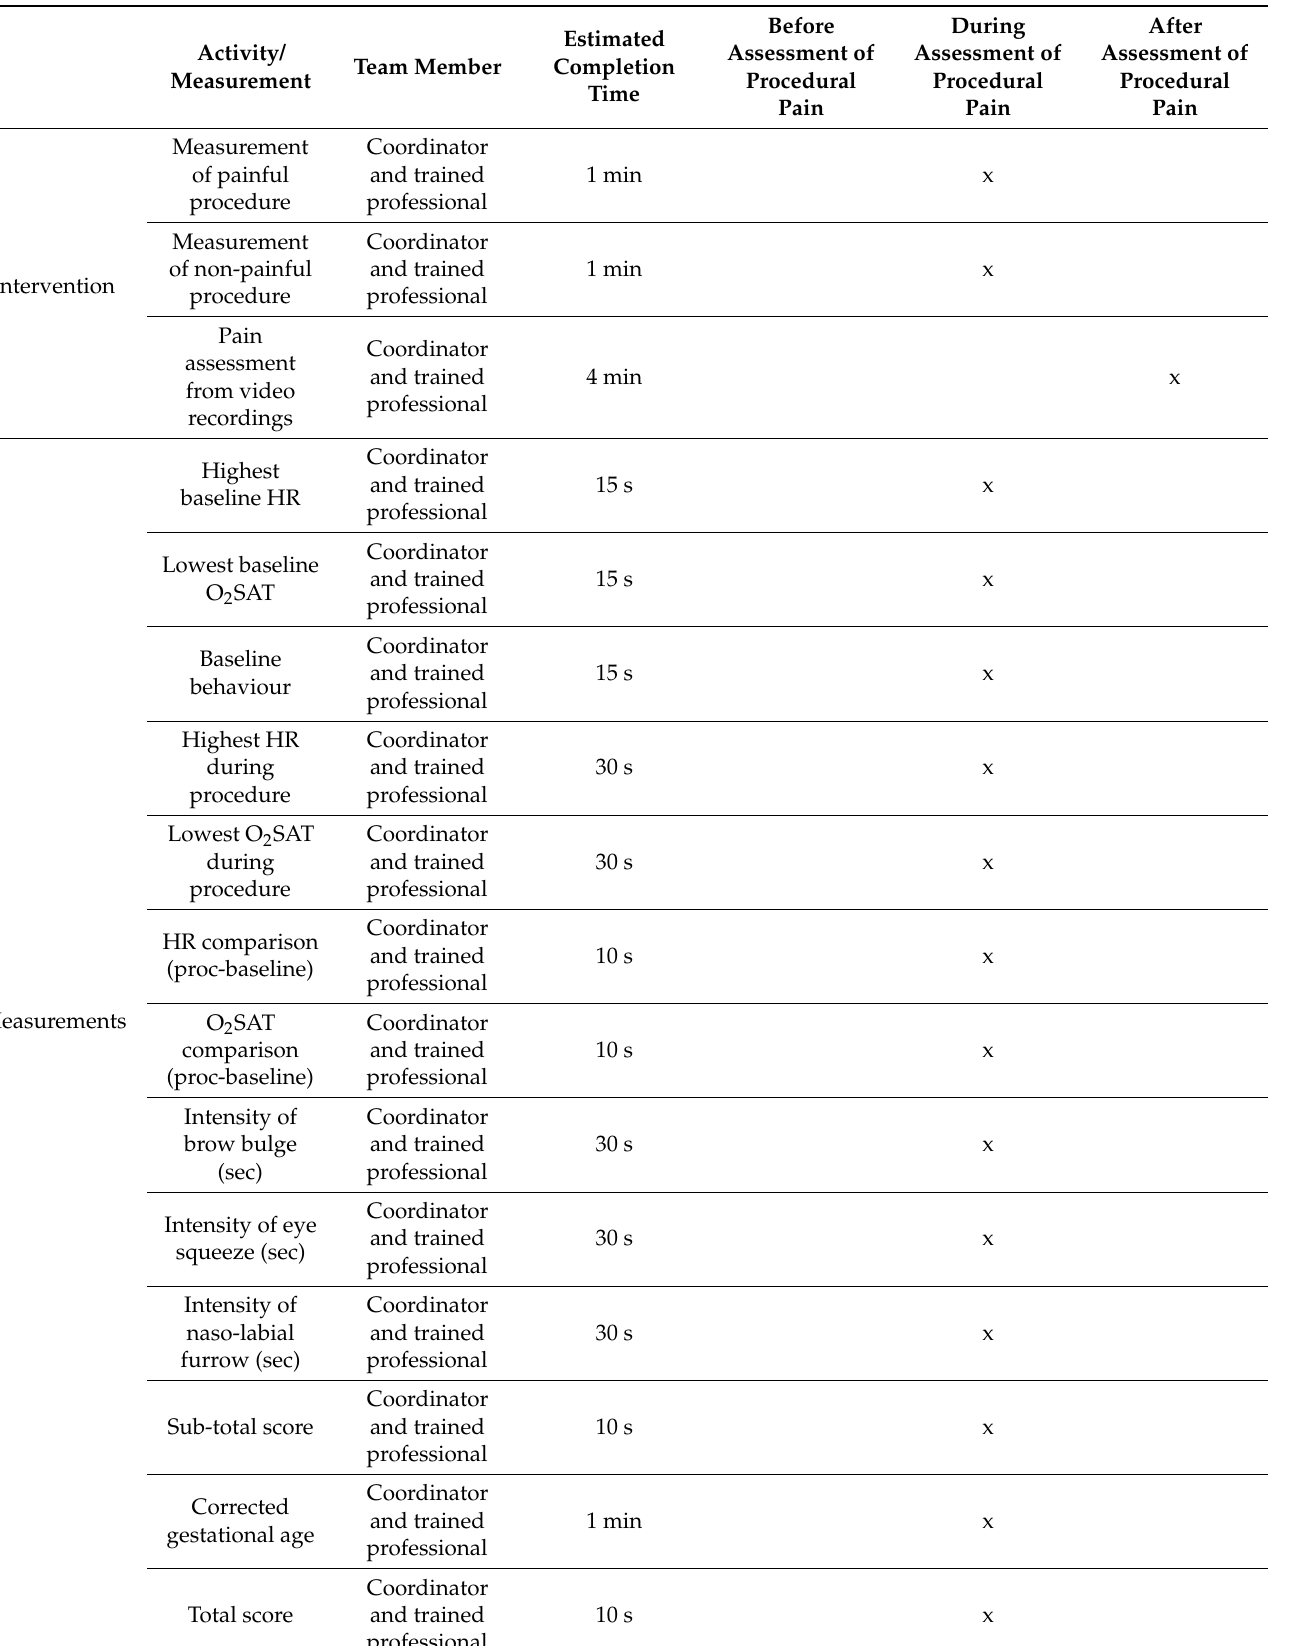
Table 3. Patient